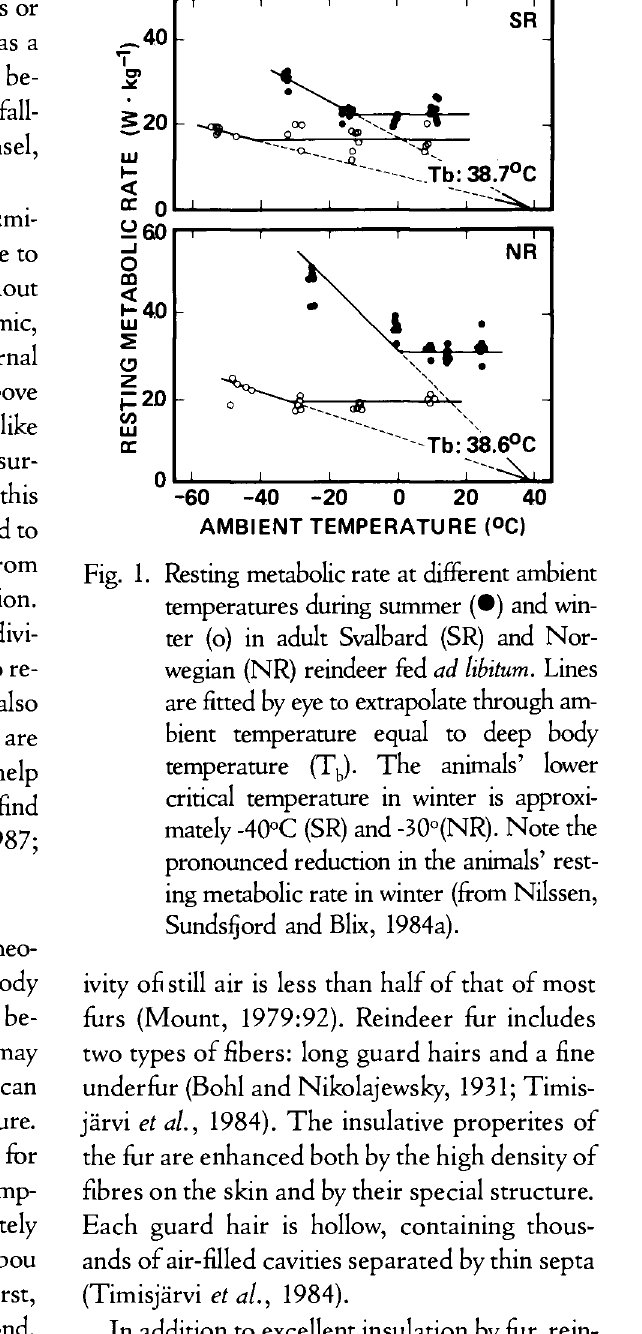
Fig. 1. Resting metabolic rate at different ambient temperatures during summer (•) and win ter (o) in adult Svalbard (SR) and Nor wegian (NR) reindeer fed ad libitum. Lines are fitted by eye to extrapolate through am bient temperature equal to deep body temperature (T ). The animals' lower b critical temperature in winter is approxi mately -40°C (SR) and -30°(NR). Note the pronounced reduction in the animals' rest ing metabolic rate in winter (from Nilssen, Sundsfjord and Blix, 1984a). ivity of still air is less than half of that of most furs (Mount, 1979:92). Reindeer fur includes two types of fibers: long guard hairs and a fine underfur (Bohl and Nikolajewsky, 1931; Timis- jarvi et al., 1984). The insulative properites of the fur are enhanced both by the high density of fibres on the skin and by their special structure. Each guard hair is hollow, containing thous ands of air-filled cavities separated by thin septa (Timisjarvi et al,